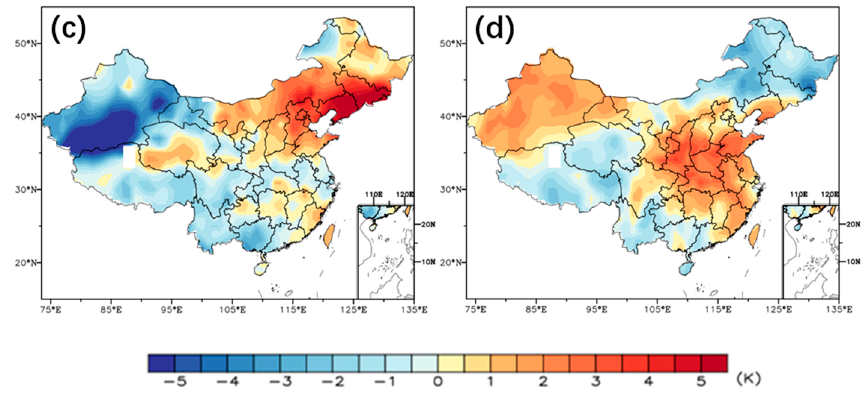
Figure 3. Composite SAT anomalies for ( a ) hot period 1 (14–20 July), ( b ) hot period 2 (20–25 July), ( c ) hot period 3 (27 July–4 August) and ( d ) hot period 4 (4-12 August).